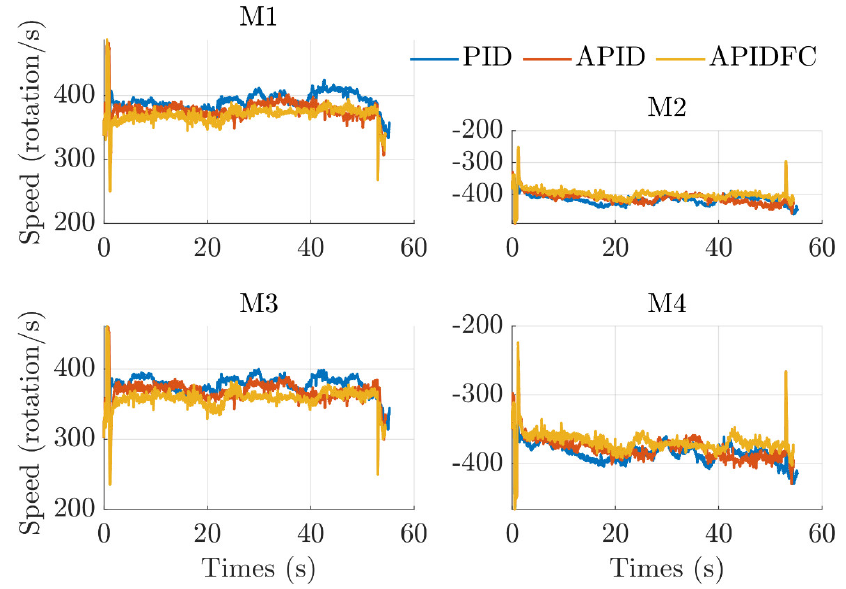
Figure 15. Motor rotation speed comparison between controllers.